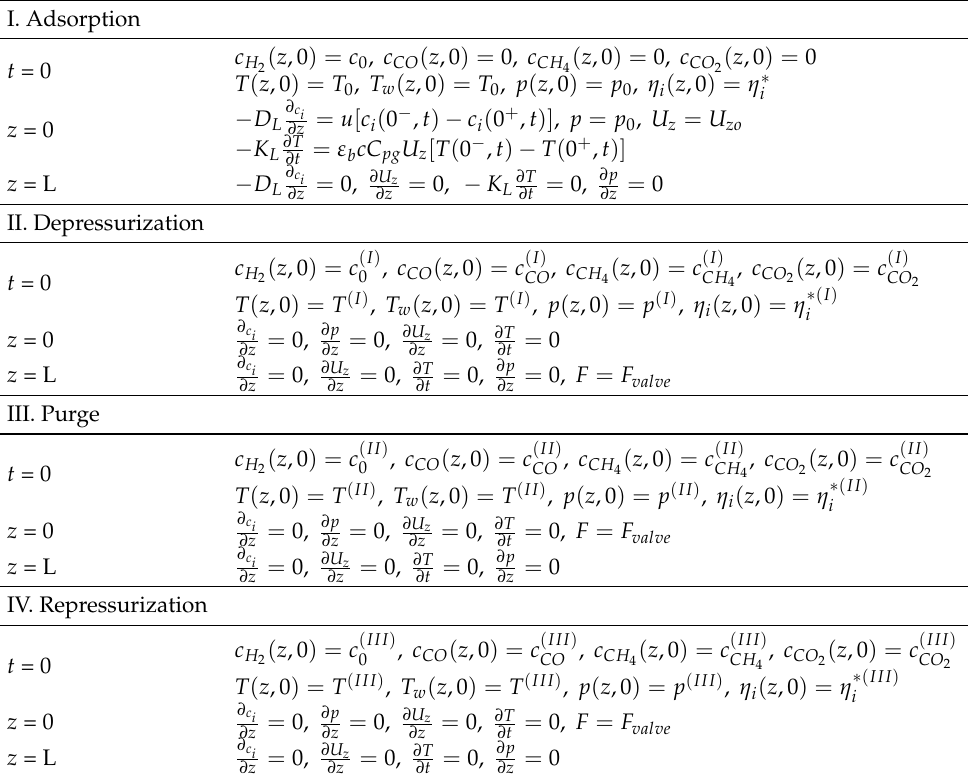
Table 1. Boundary and initial